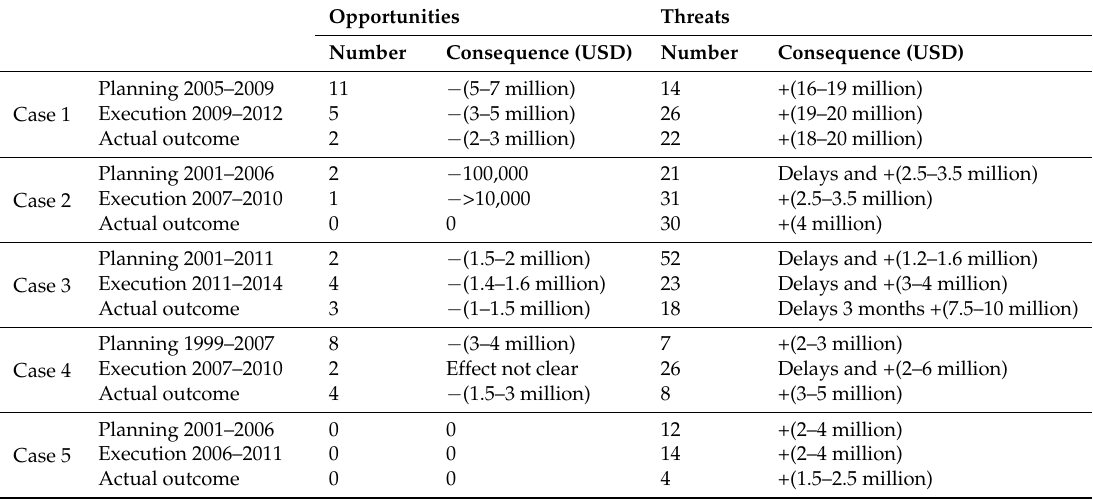
Table 2. Threats and opportunities in the planning and execution phase of public sector projects